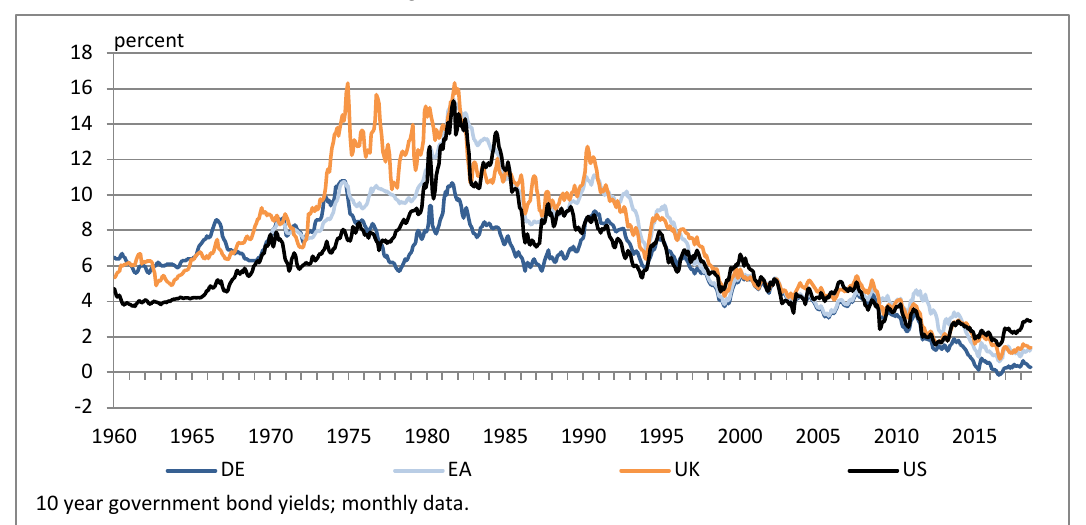
Figure 7: Nominal interest